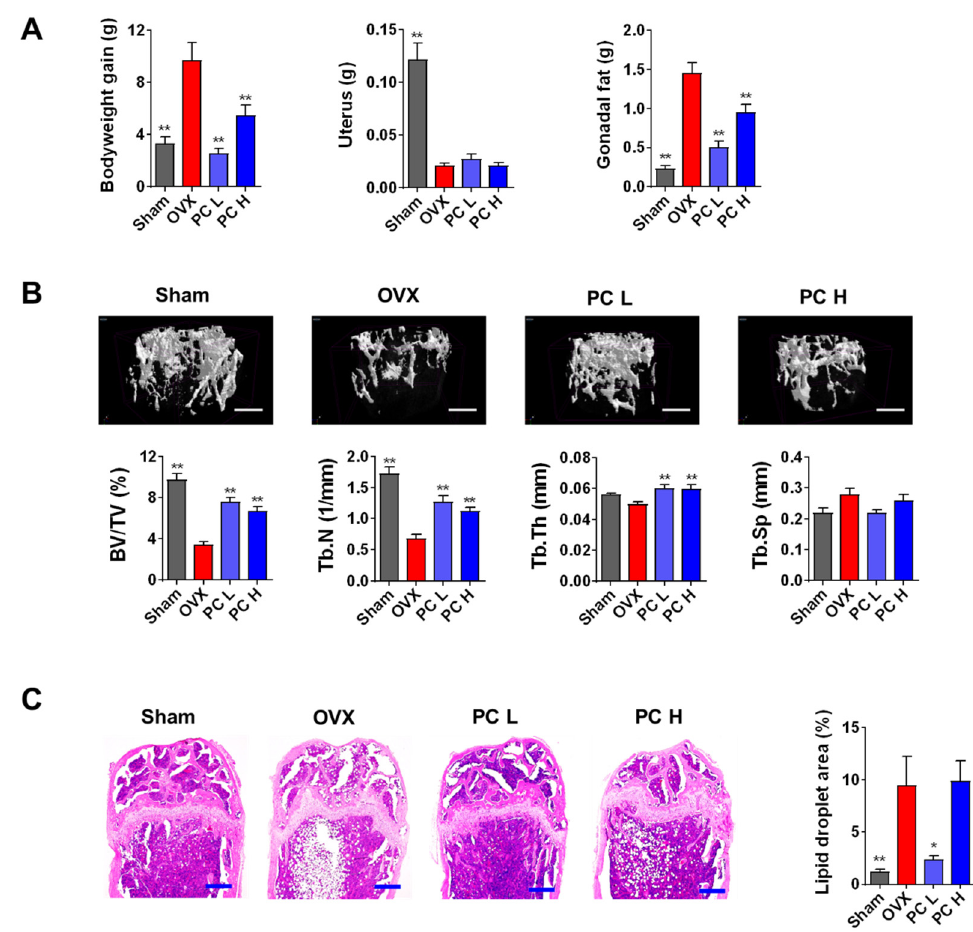
Figure 2. PC alleviates estrogen-deficiency- and high-fat-diet-induced bone loss and lipid accumulation in mice. ( A ) Body weight gain, uterine weight, and gonadal-fat weight during the experimental period. ( B ) Bone microarchitecture (scale bar, 0.5 mm) and trabecular bone parameters as shown by micro-computed tomography. ( C ) Marrow lipid droplets after hematoxylin and eosin staining (scale bar, 250 µ m). Sham, sham-operated / vehicle; OVX, OVX / vehicle; PC L, OVX / low-dose PC treatment (10 mg / kg / day); PC H, OVX / high-dose PC treatment (20 mg / kg / day). BV / TV, bone volume to tissue volume ratio; Tb.N, trabecular number; Tb.Th, trabecular thickness; Tb.Sp, trabecular separation. Data are expressed as mean ± SEM ( n = 8). * p < 0.05, ** p < 0.01 vs. OVX